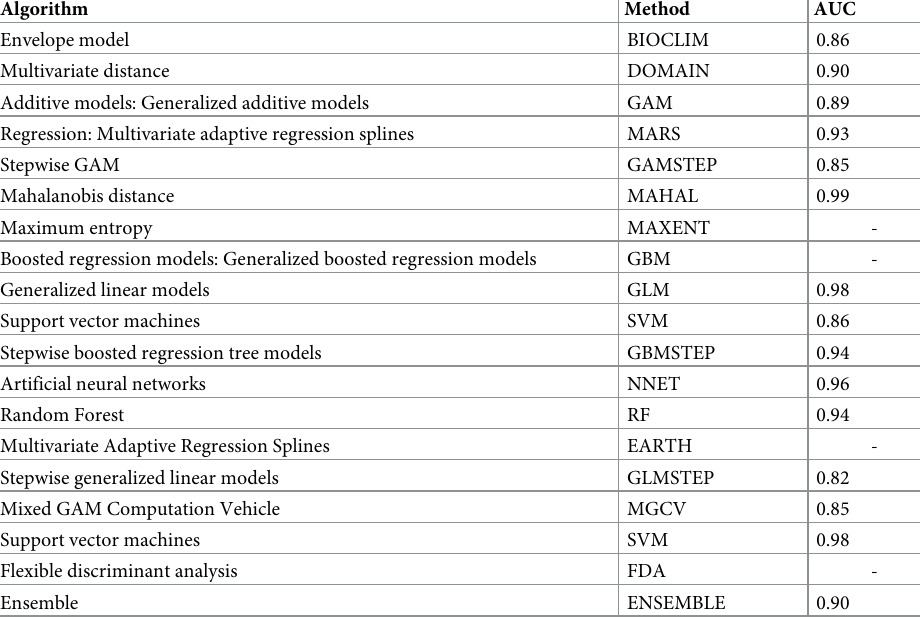
Table 2. Performance evaluation of the ensemble